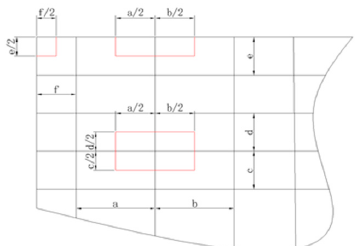
Figure 12. Schematic diagram of the force area calculation for the spring element.